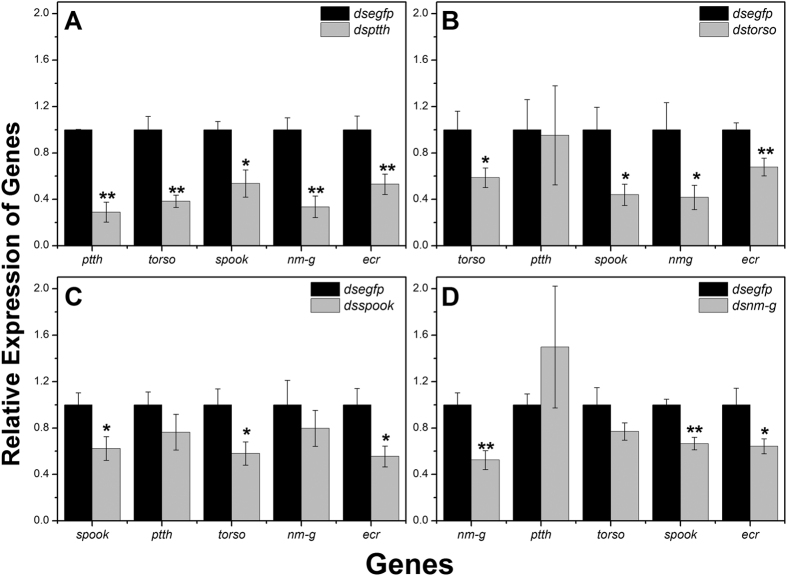
Relative mRNA abundance of the five 20E synthesis genes after RNAi-treated with dsptth (A), dstorso (B), dsspook (C) and dsnm-g (D).The mRNA levels of genes were monitored by q-PCR at 72 h after feeding. Larvae fed with dsegfp were used as negative control. Asterisk shows significant difference (*p < 0.05 and **p < 0.01, Student’s t-test).